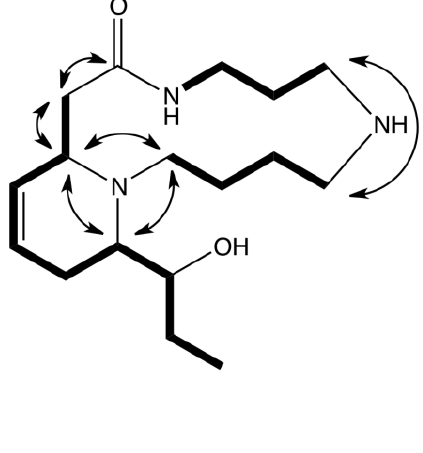
Figure 2. Selected COSY ( bold ) and HMBC correlations of compound 2a